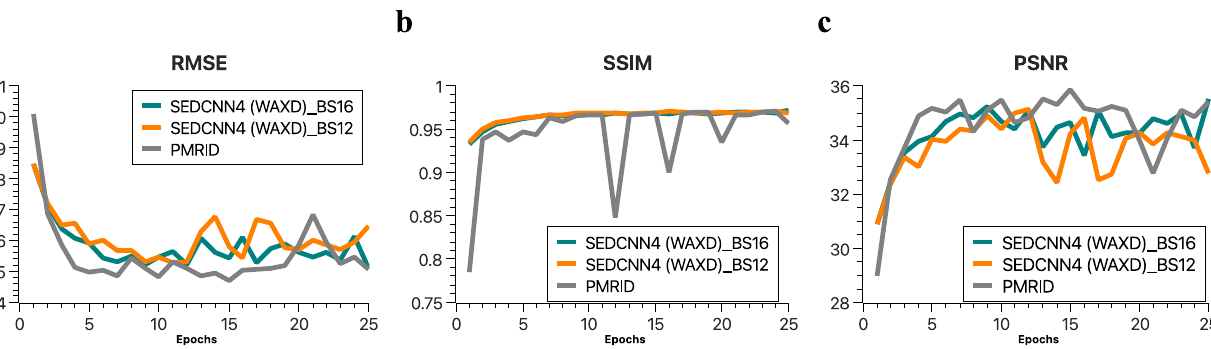
Fig. 8 Performance on WAXD dataset. a RMSE, b SSIM, and c PSNR comparison between SEDCNN4 (WAXD, batch size equaling 12 and 16) and PMRID on the testing dataset. Labels on y axes: all in arbitrary